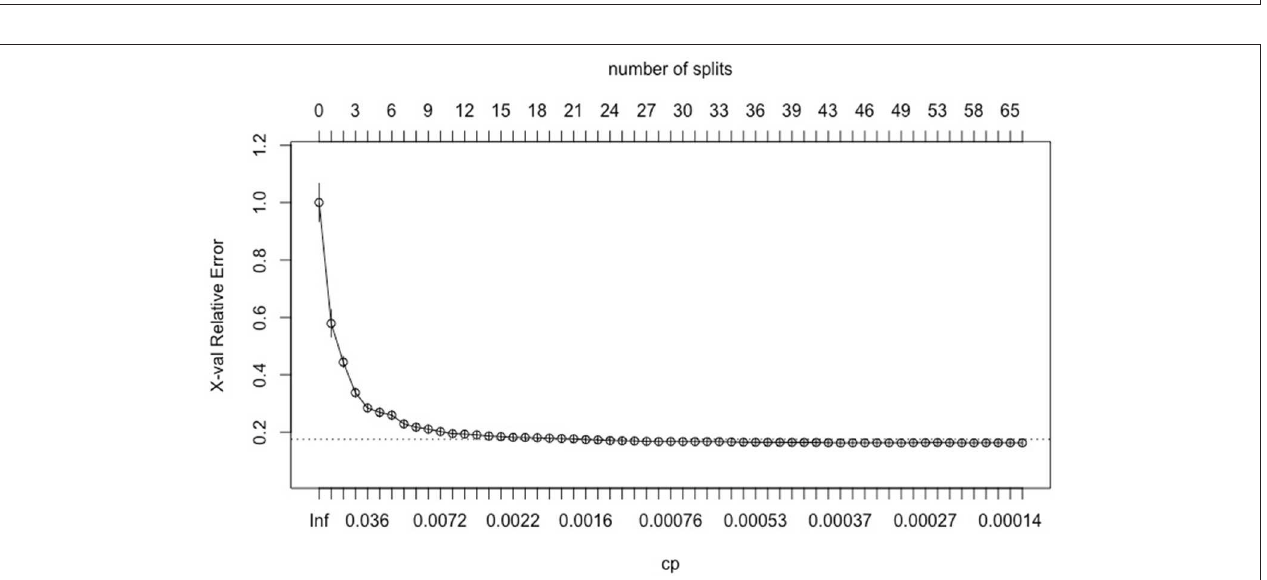
FIGURE 3 | Effect of the tree size (number of splits) along the top compared with the relative cross validated error. Cp along the bottom refers to the control parameter used in the R package rpart to determine the size of the tree (Year 3).